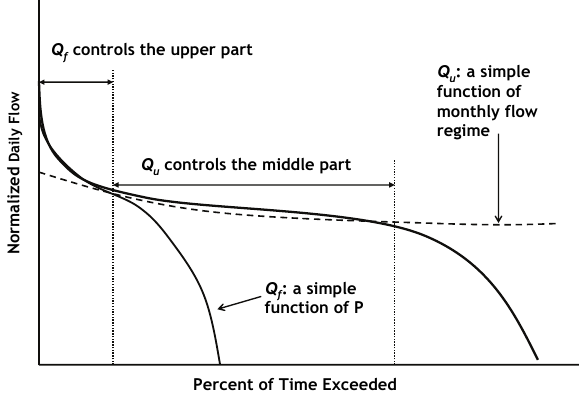
Fig. 2. Conceptual model of the controls on the FDC (adapted from Yokoo and Sivapalan, 2011); here Q f is the fast flow (surface runoff) and Q u is the slow flow (sub-surface